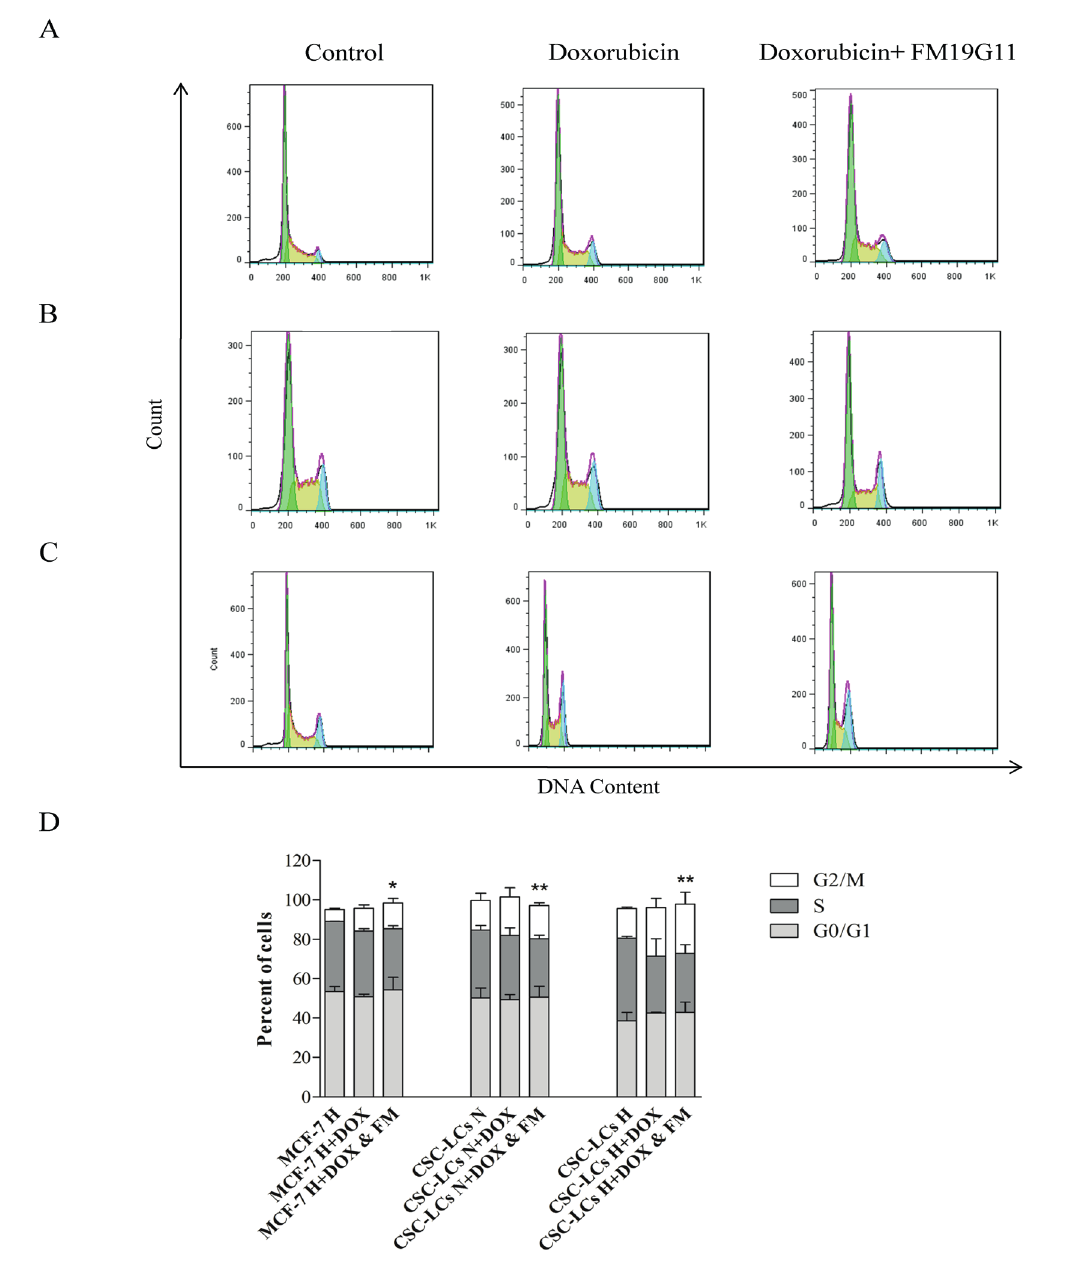
FIGURE 4 - Exposure to doxorubicin (DOX) and FM19G11 (FM) in hypoxic (H) and normoxic (N) conditions induced G2 phase cell cycle arrest. (A) MCF-7 cells in hypoxic condition; (B) CSC-LCs in normoxic condition; (C) CSC-LCs in hypoxic condition; (D) Cell cycle diagram . * P < 0.05, and ** P < 0.01 as compared to control group were referred to G2/M